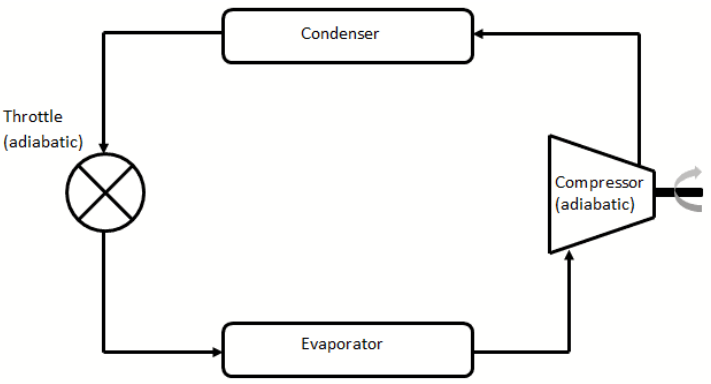
Figure 5. Process diagram of simple vapor compression cooling system.